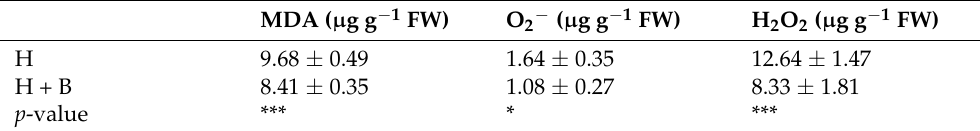
Table 2. Stress indicators in sunflower plants subjected to the treatments.